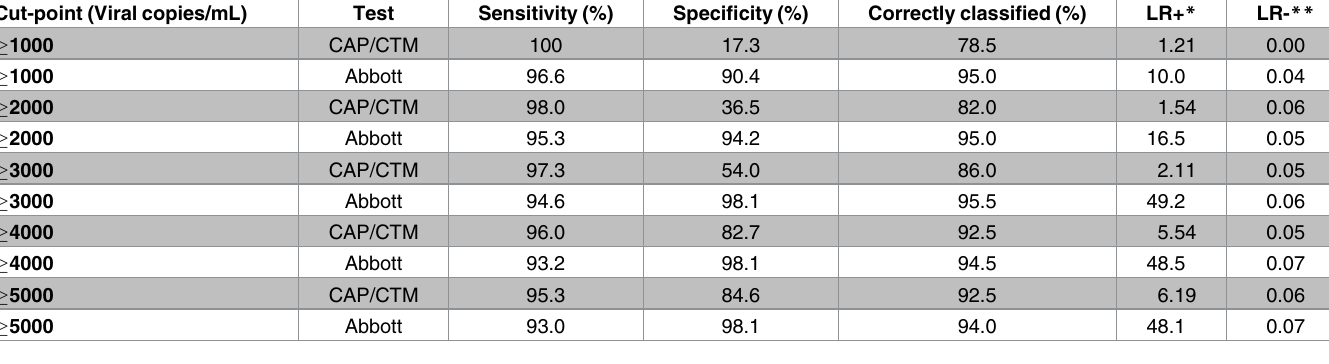
Table 4. Comparisons between CAP/CTM dried blood spot and Abbott dried blood spot tests at different cut-offs using CAP/CTM plasma as the gold standard. Cut-point (Viral copies/mL)